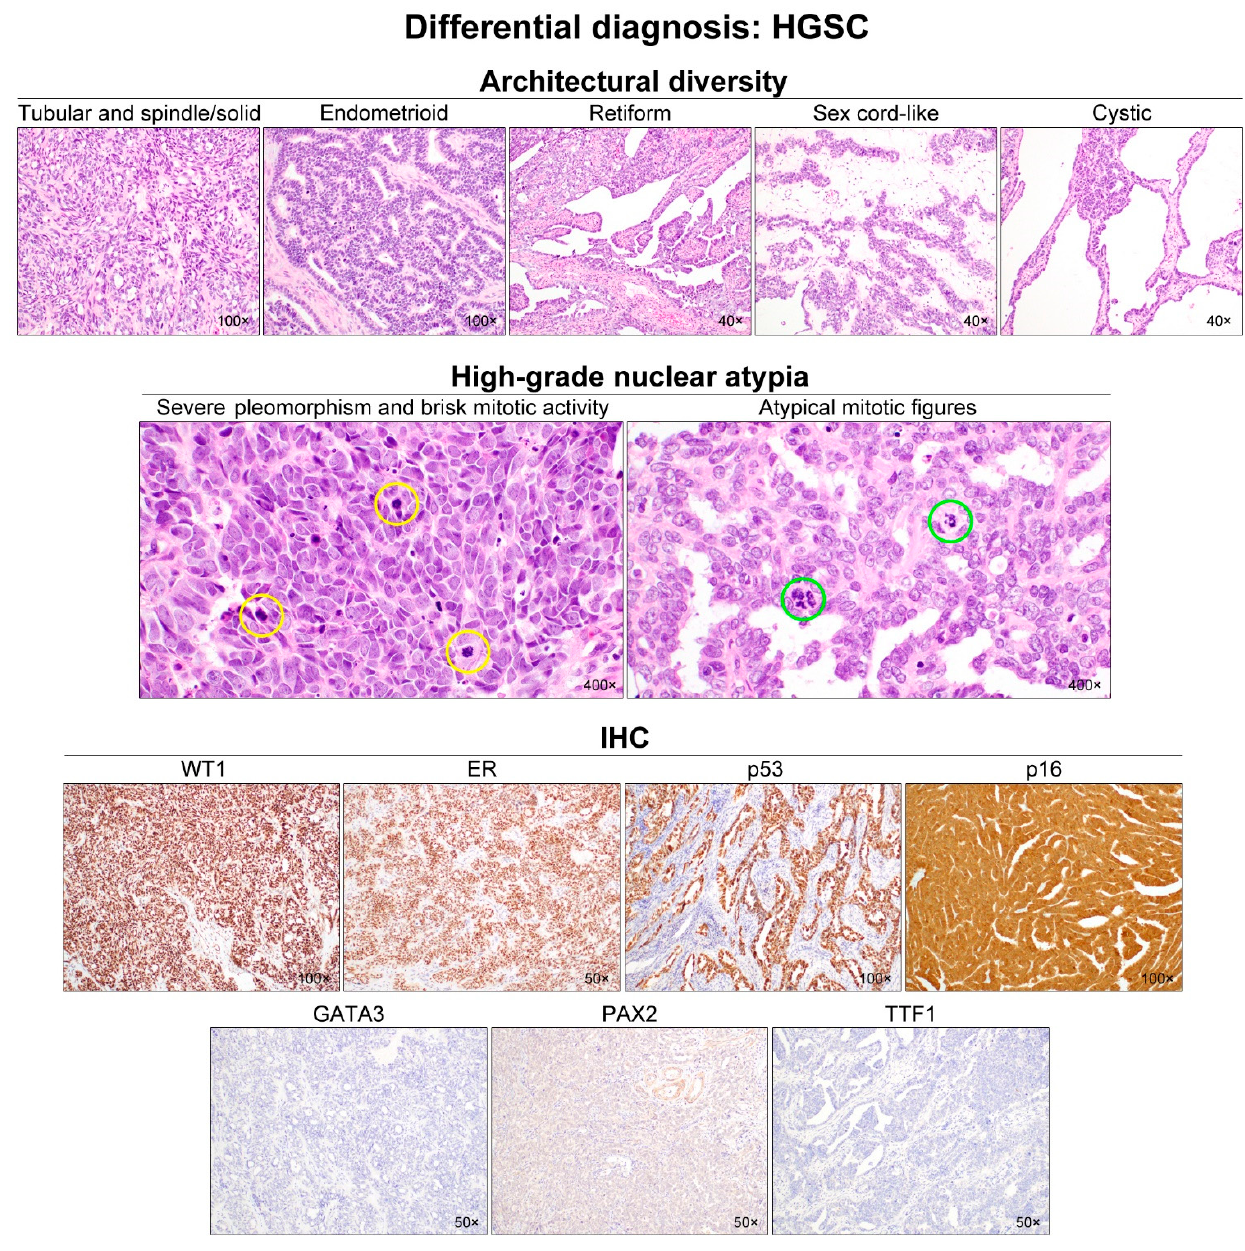
Figure 7. Differential diagnosis of ovarian MLA: HGSC. In addition to papillary and solid structures, HGSC can exhibit various growth patterns including tubular, spindle, endometrioid, retiform, sex cord-like, and cystic. Diverse architectural patterns and the presence of intraluminal secretions may raise the possibility of MLA. However, when a high-grade nuclear atypia, including severe-to- marked nuclear pleomorphism and hyperchromasia, brisk mitotic activity (yellow circles), and readily identifiable atypical mitotic figures (green circles), is observed throughout the tumor, the diagnosis of HGSC is preferred. Nevertheless, as shown in case 1, since MLA can also show severe nuclear pleomorphism and increased mitotic activity, immunostaining is recommended to differ- entiate between HGSC with mesonephric-like differentiation and MLA. The following immunopro- files indicate HGSC: uniform nuclear WT1 and ER expression; p53 overexpression; diffuse and strong nuclear and cytoplasmic p16 immunoreactivity; and a lack of mesonephric marker (GATA3, PAX2, and TTF1) expression. MLA has been reported to show negative or patchy p16 expression.